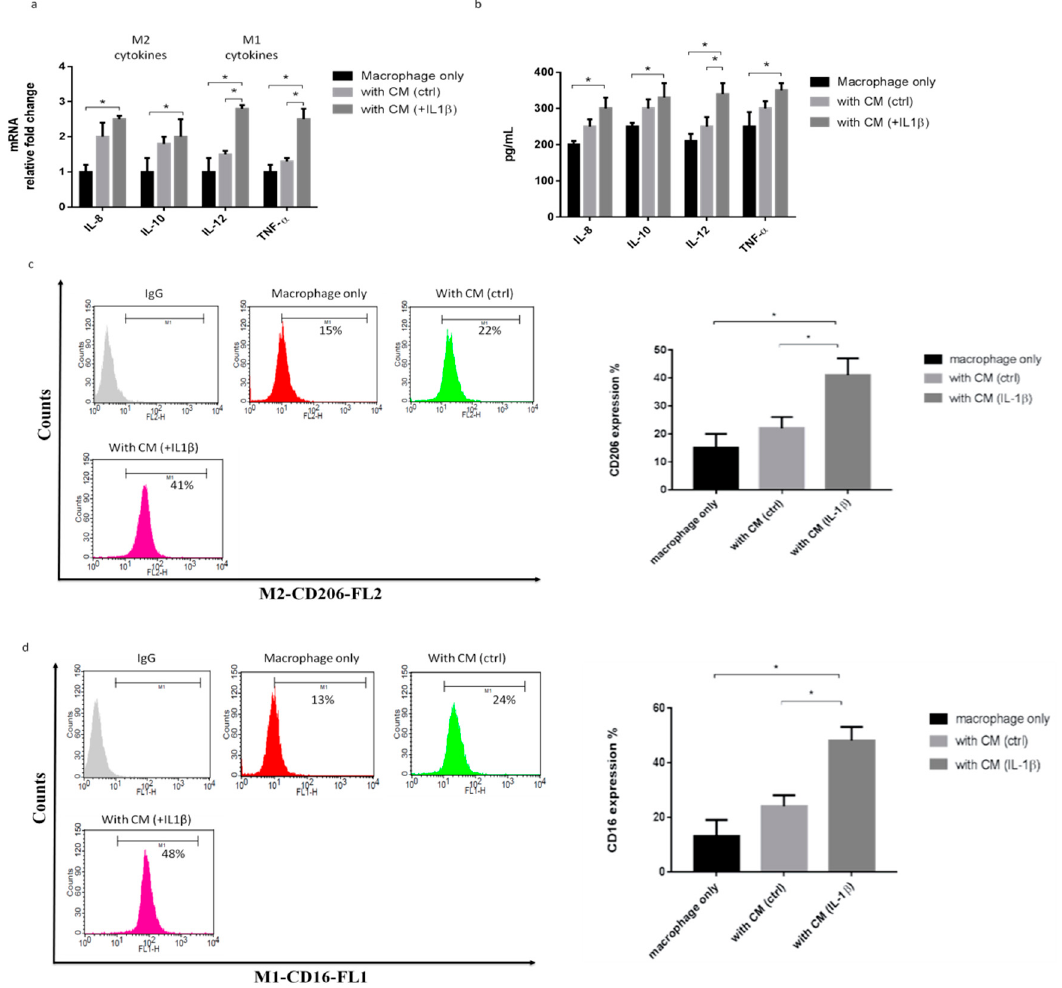
Figure 2. IL-1 β -treated primary synoviocytes affected M1/M2 polarization. The primary synoviocytes were treated with IL-1 β (10 ng/mL) for 24 h and then replaced with fresh medium; 24 h later, the CM was collected to treat THP-1 cells. ( a ) Quantitative PCR analysis of IL-8, IL-10, IL-12, and TNF- α . ( b ) ELISA analysis of IL-8, IL-10, IL-12, and TNF- α . ( c , d ) Flow cytometry analysis of the expression of CD206, a marker of M2, and the expression of CD16, a marker of M1. Data are expressed as the mean ± SD, * p < 0.05. IgG as a negative control. The data presented are representative of three independent experiments.